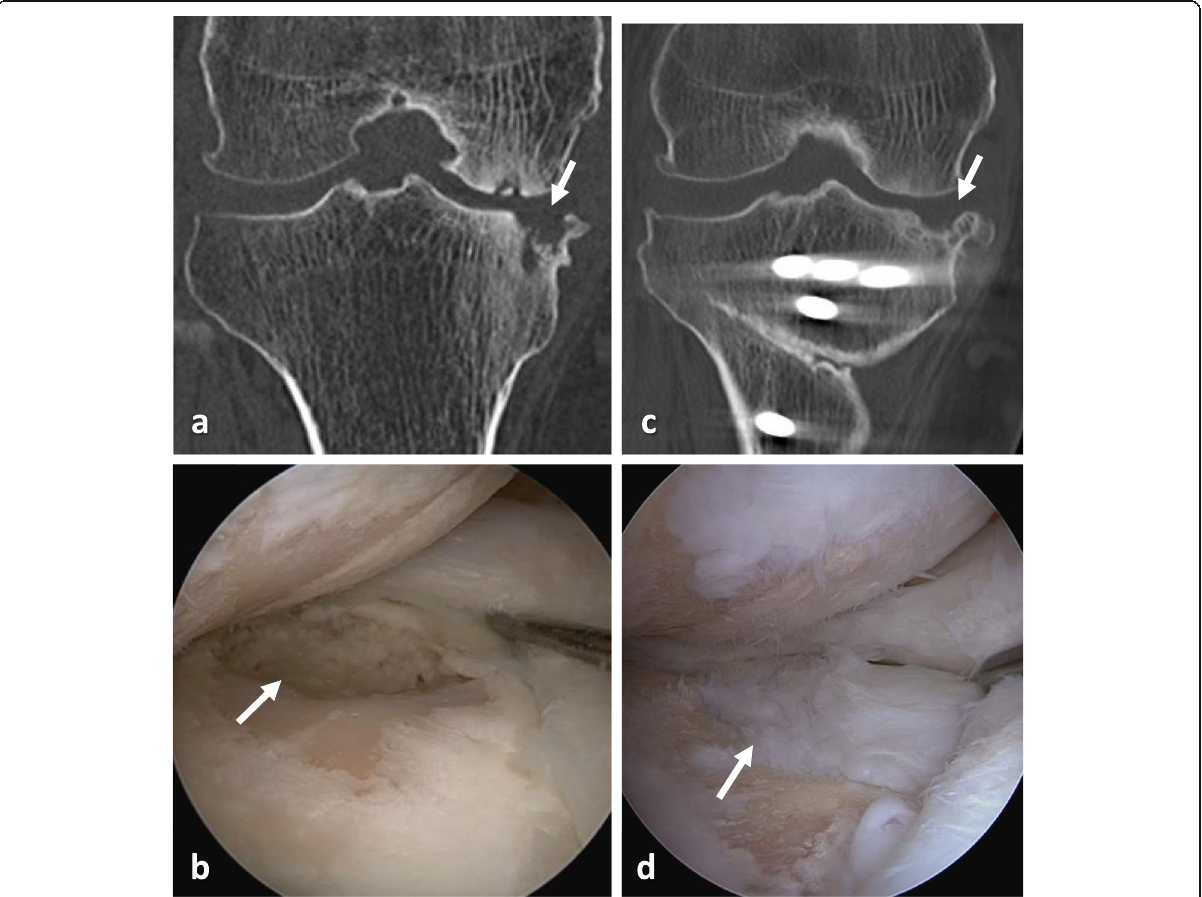
The MRI findings are shown in Table 4. In the cor- onal plane, all cases were in the medial region. In the sagittal plane, five cases were in the anterior and central region, four were in the anterior region, and three were in the central region. The mean percent-